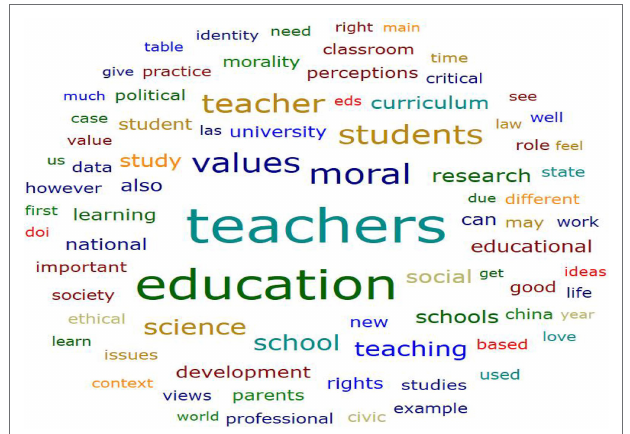
FIGURE 3 | Word cloud on word frequencies from 32 retrieved